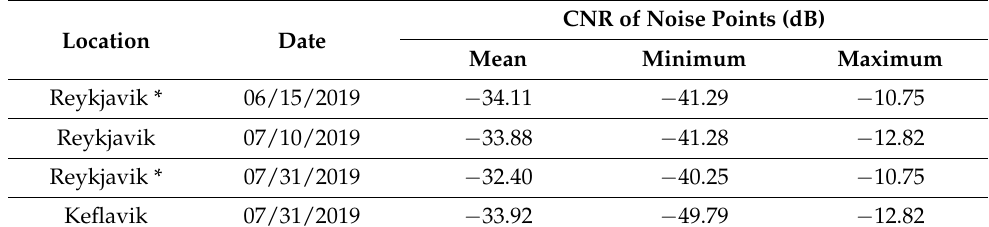
Table 3. CNR value for model classified noise data points.